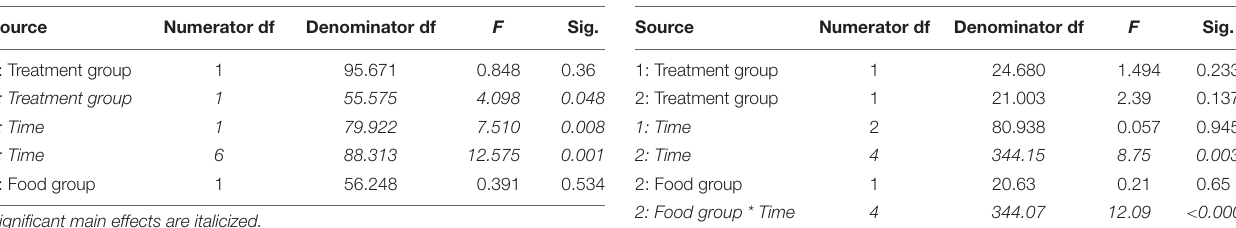
TABLE 5 | Fixed effects from the linear mixed effects model of baseline corticosterone levels in study 1 (indicated by 1) and study 2 (2) between treatment groups, food groups and across time.